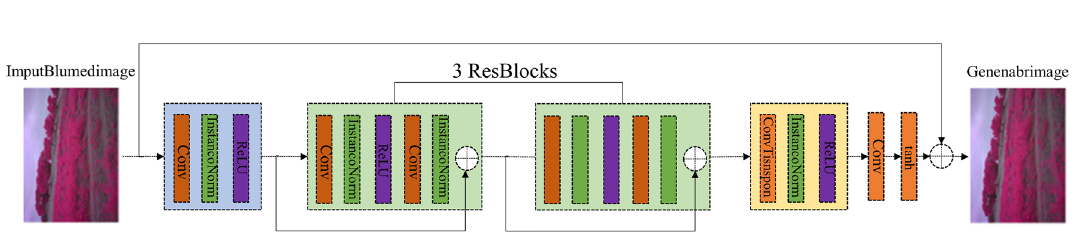
Figure 4. Network structure of the LSTM block and the IndRNN block of the decoding module.